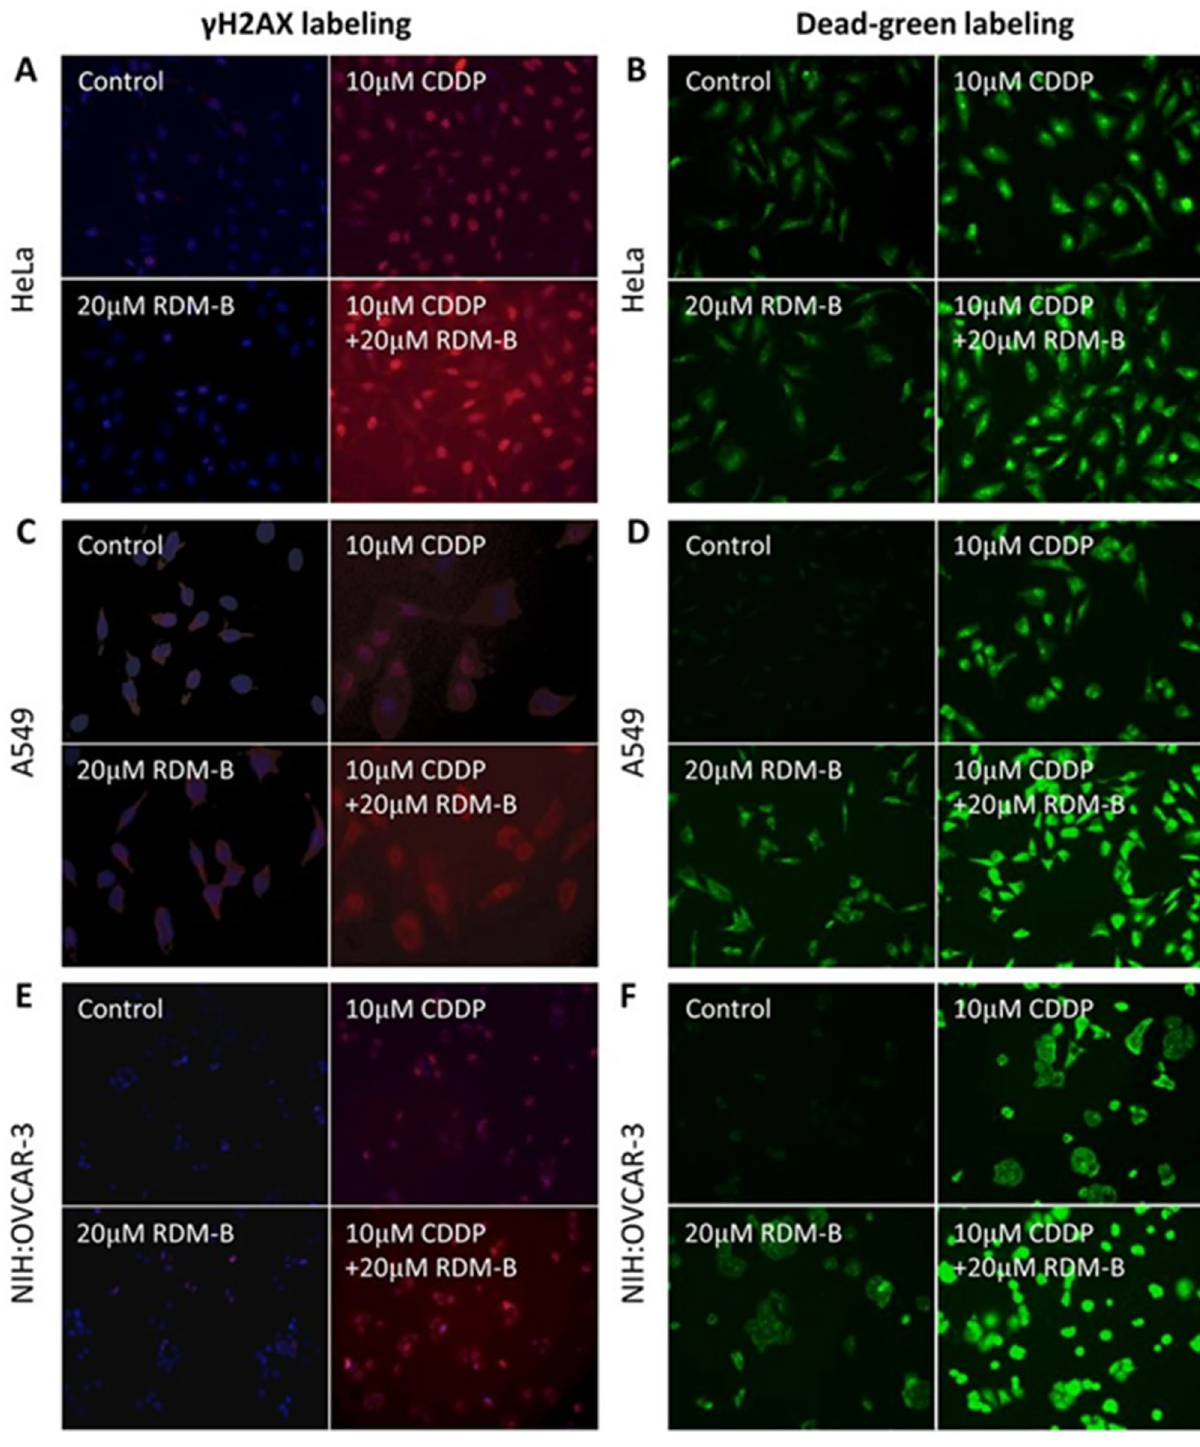
Figure 2. Cellular DNA DSB measurements in different cancer cell lines using γH2AX labeling. Representative pictures of γH2AX labeling are shown in ( A ), ( C ) and ( E ), and those of dead green staining are shown in ( B ), ( D ) and ( F ) in HeLa, A549 and NIH:OVACR-3 cells, respectively, with the treatments